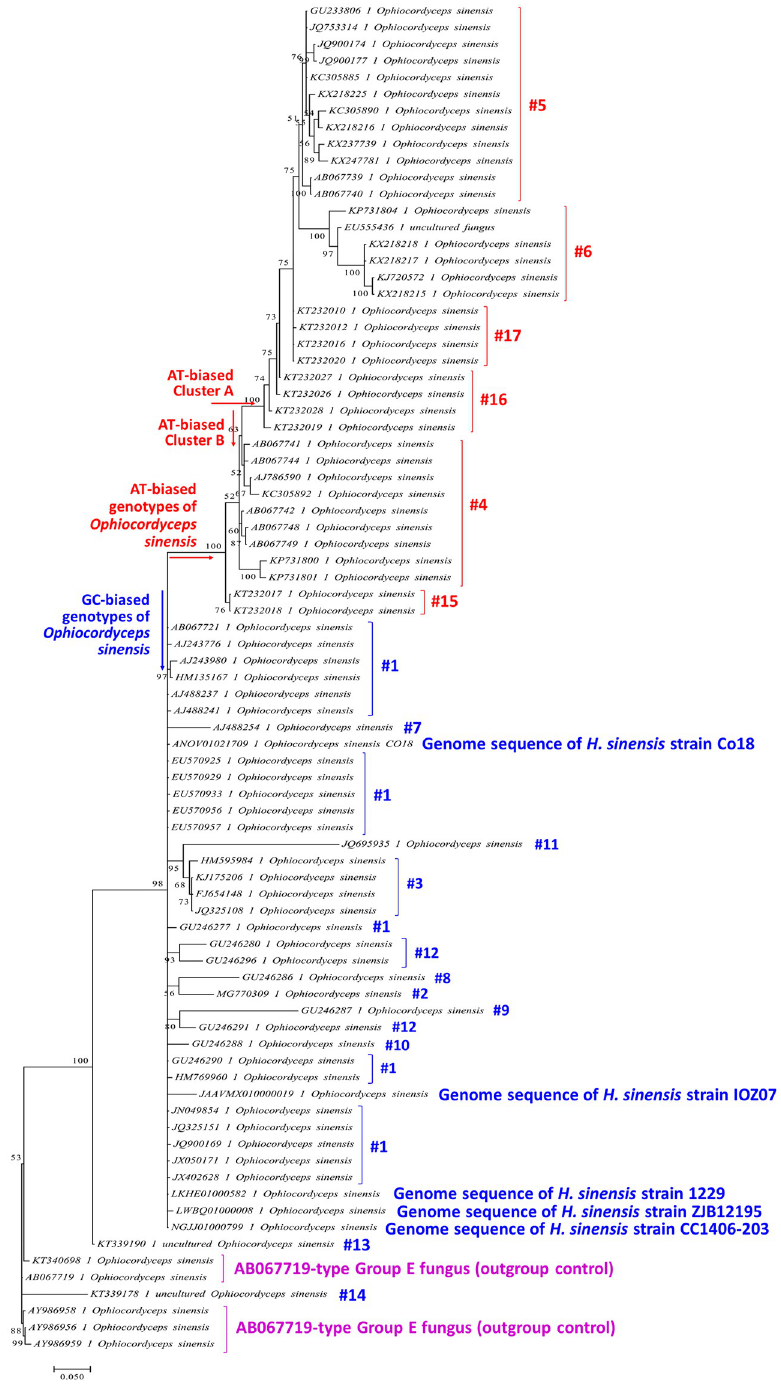
Fig 7. Bayesian phylogenetic analysis of multiple genotypes of O . sinensis . Five ITS sequences of the whole genomes (ANOV01021709, LKHE01000582, LWBQ01000008, JAAVMX010000002 and JAAVMX010000019) of H . sinensis strains (Co18, 1229, ZJB12195 and IOZ07) and 71 ITS sequences of 17 genotypes of O . sinensis were analyzed. The Bayesian majority-rule consensus tree was inferred using MrBayes v3.2.7a software (Markov chain Monte Carlo [MCMC] algorithm) [75]. GC-biased Genotypes #1–3 and #7–14 of O . sinensis are indicated in blue alongside the tree, and the AT-biased Genotypes #4–6 and #15–17 of O . sinensis are indicated in red alongside the tree. The AB067719-type Group-E sequences (5 sequences) are indicated in purple alongside the tree as an outgroup control.